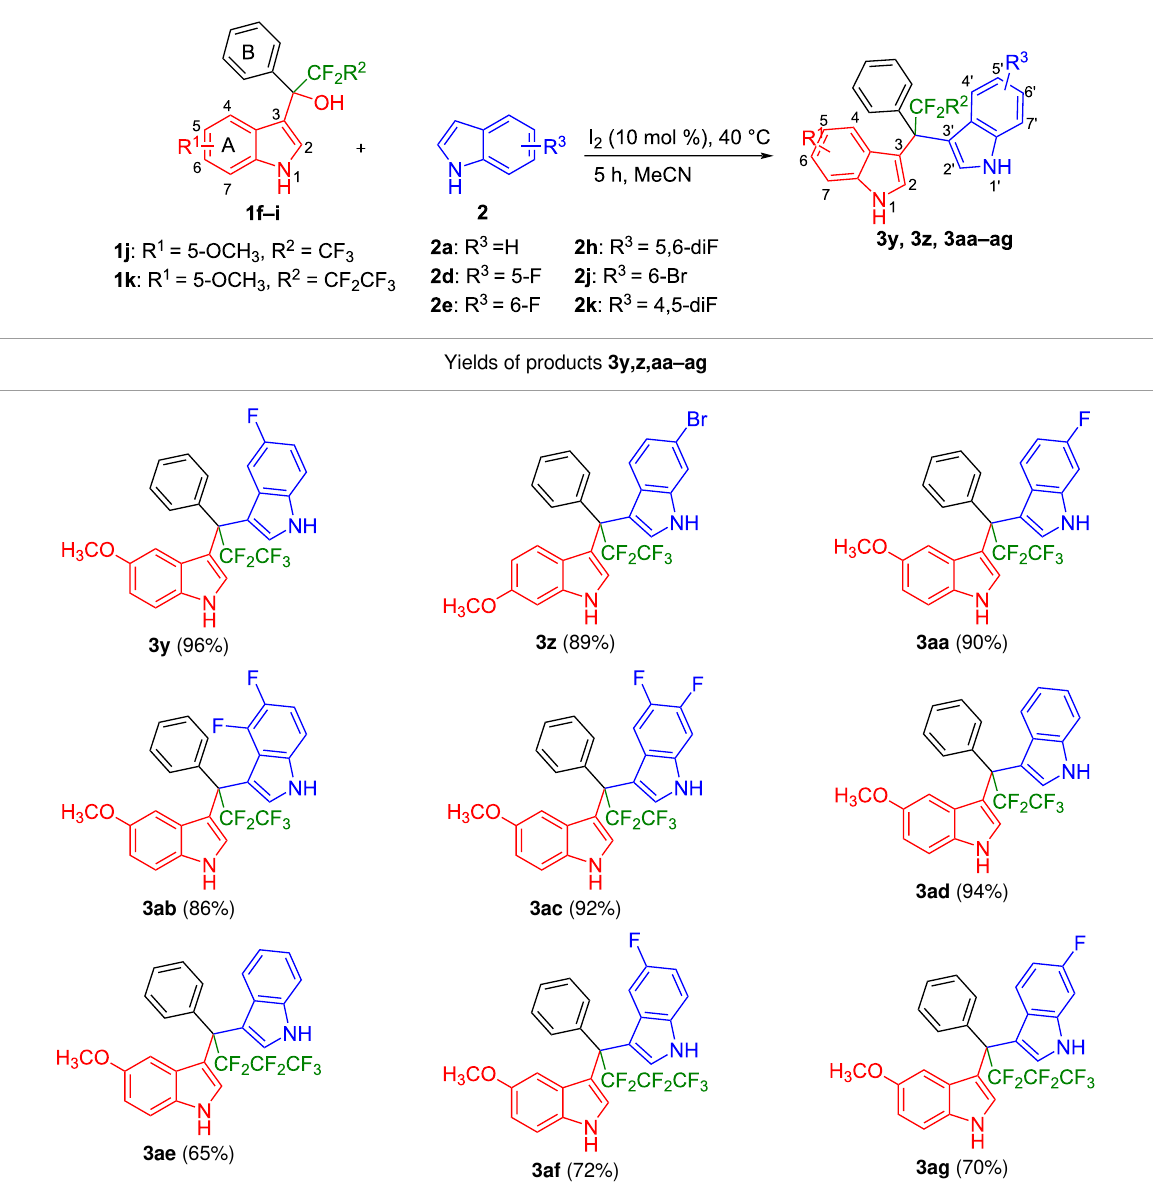
Yields of products